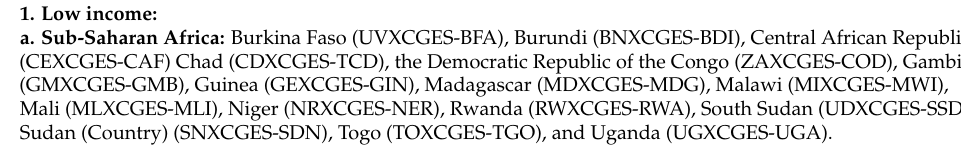
Table 2. Country classifications (the Refinitiv code for the economic support index of the relevant country and the country abbreviation are shown in